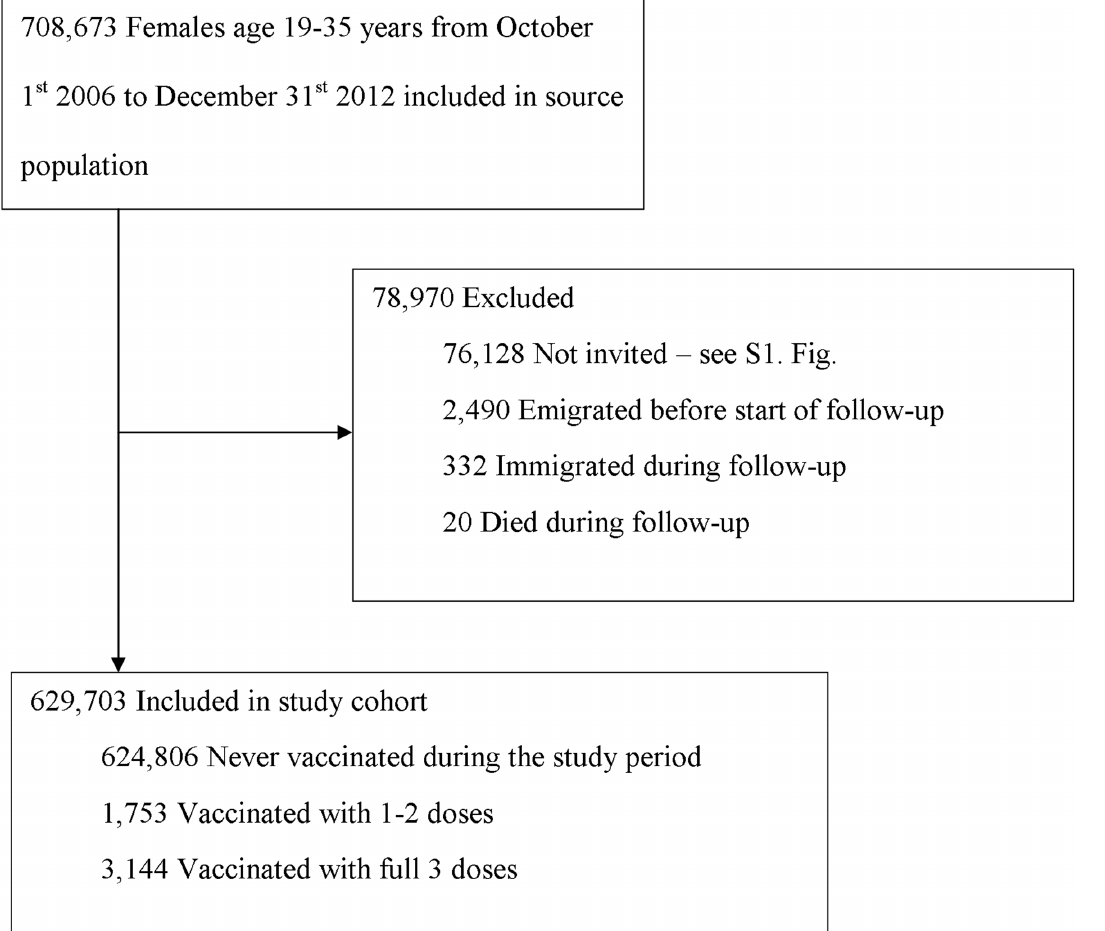
Fig 1. Details on study exclusions and population analyzed to study the association between HPV vaccination status and attendance to cervical screening after invitation.